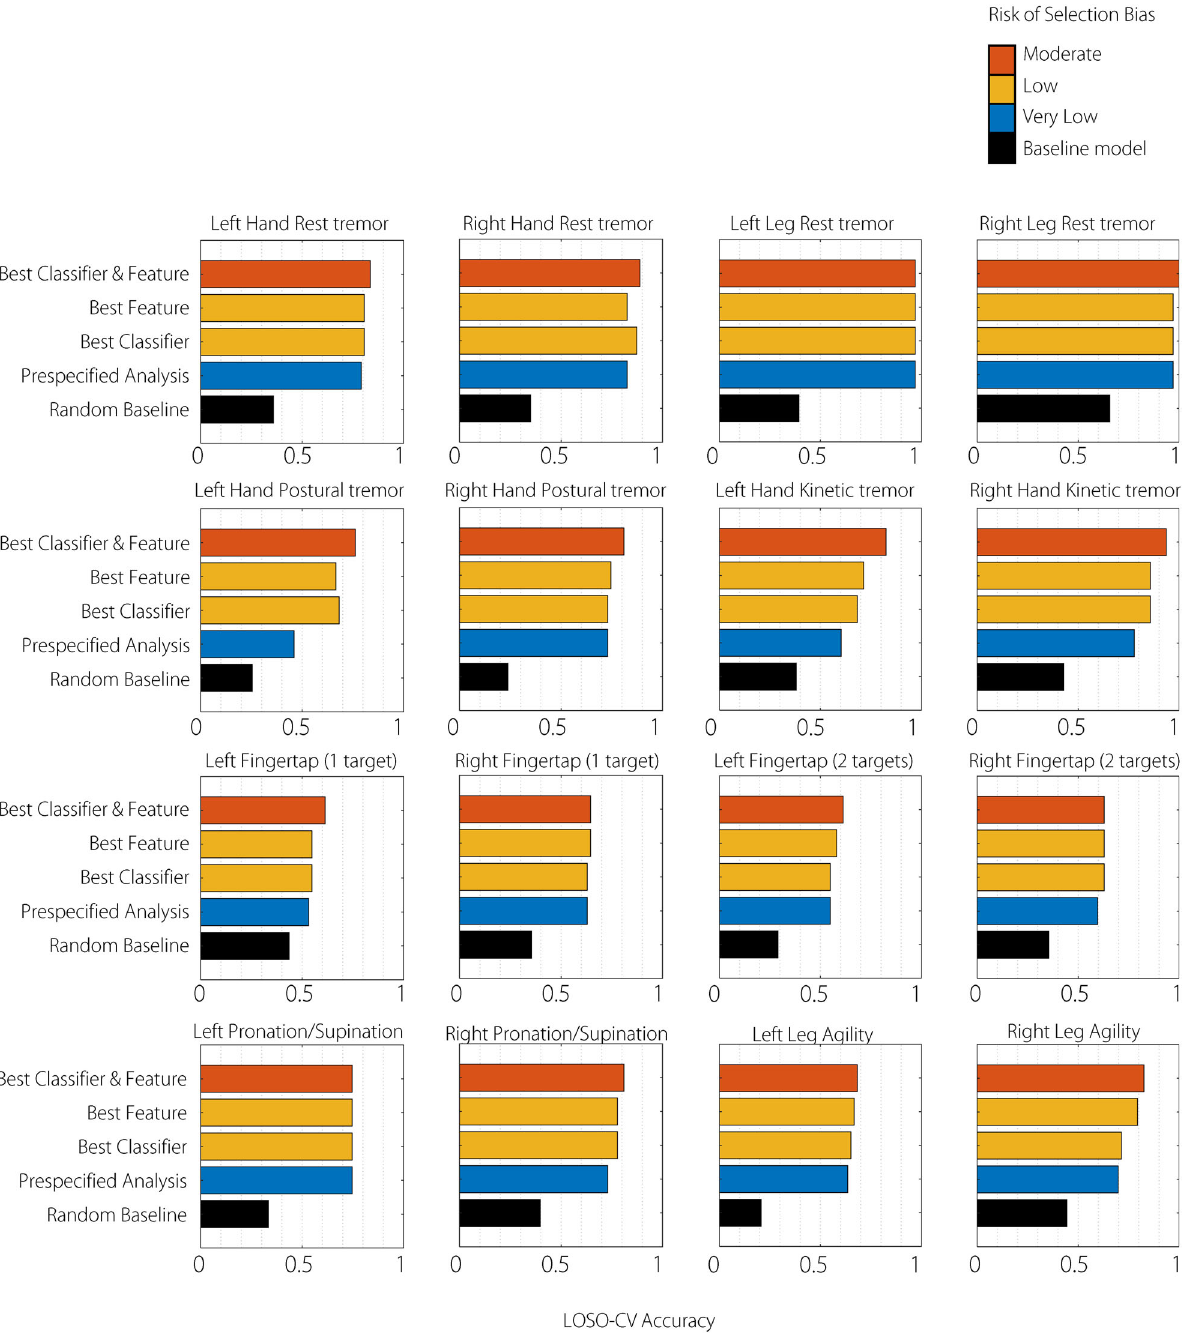
Fig. 3 Individual Test Prediction Accuracy (any-rater criterion). The leave-one-subject-out cross-validation (LOSO-CV) classi fi cation accuracy of individual subtest smartphone-based prediction of the blinded MDS-UPDRS III subitems. Baselines and models are described in the legend to Fig. 2. Subtests relate to the corresponding MDS-UPDRS III subitems. Note that the Finger tapping MDS-UPDRS III subitem is repeated because it is predicted by two smartphone tasks (one or two target